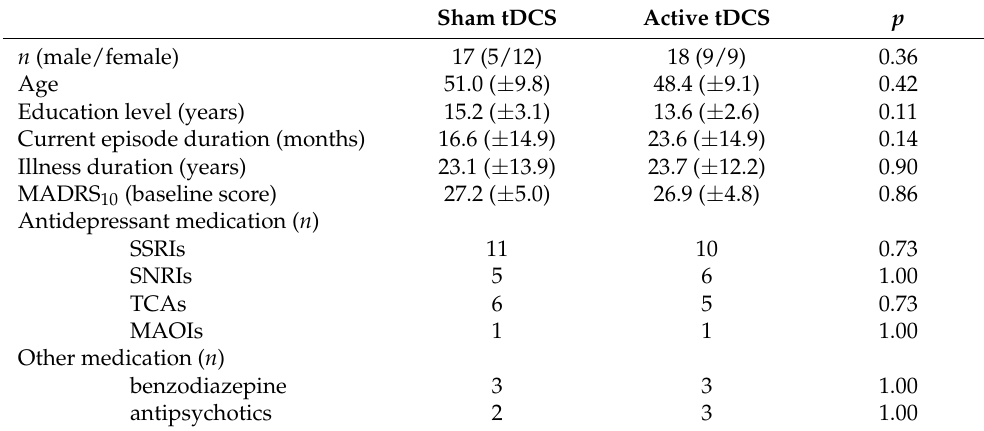
Table 1. Clinical and sociodemographic characteristics of the population included in the